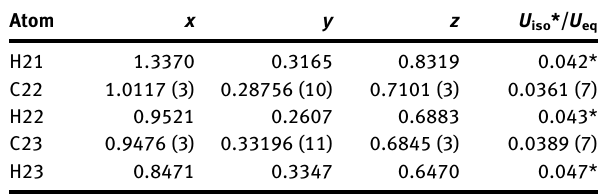
Table  : Fractional atomic coordinates and isotropic or equivalent isotropic displacement parameters (Å 